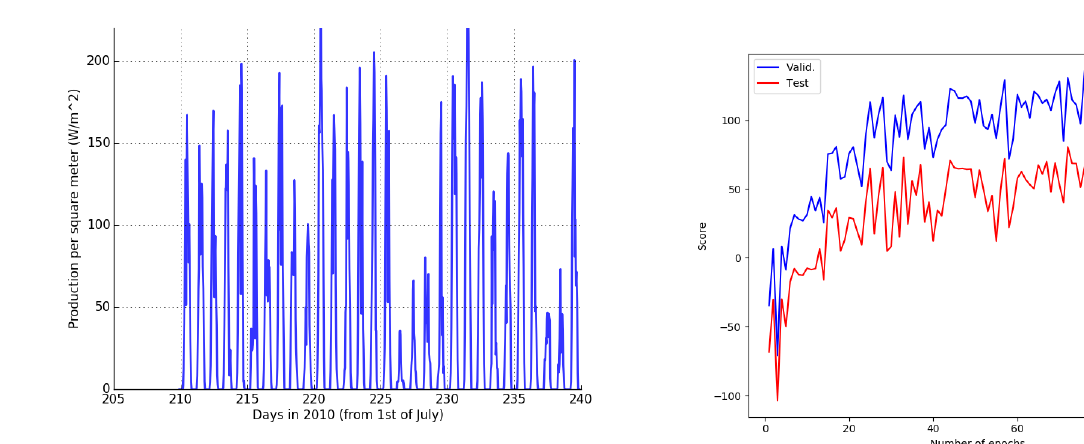
Fig. 12. Operational revenue 𝑀 𝑦 for the Case 1